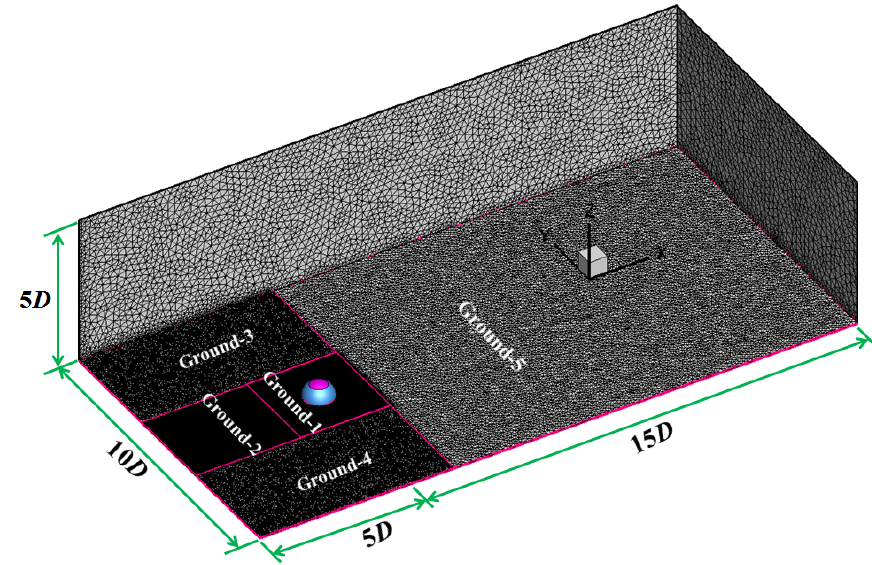
Figure 4. Computational domain and the mesh distribution.